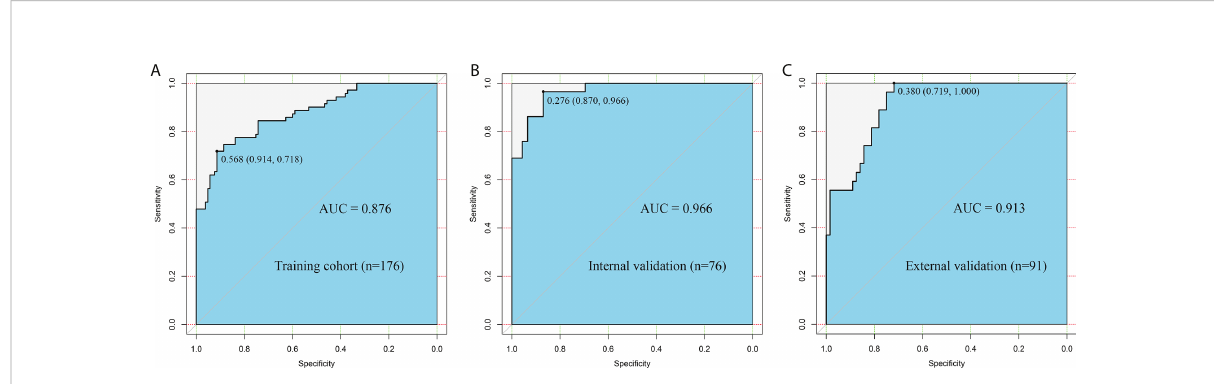
FIGURE 4 The ROC curves of the radiomic signature in the (A) training cohort, (B) internal validation cohort, and (C) external validation